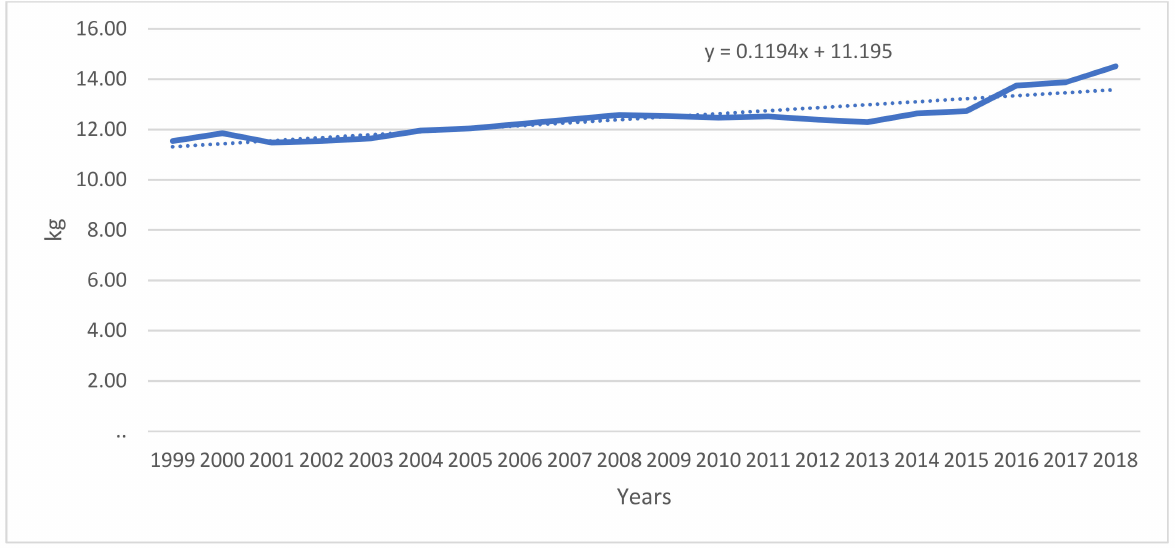
Figure 3. Total Cheese Sales in kg per Capita (Canada, 1999 to 2018). Source: Statistics Canada,